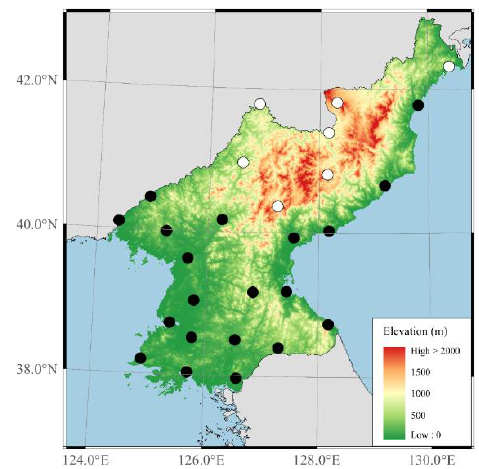
Figure 1. Topographic map of North Korea. Black and white circles indicate the weather stations for the early- and main-season potatoes, respectively.